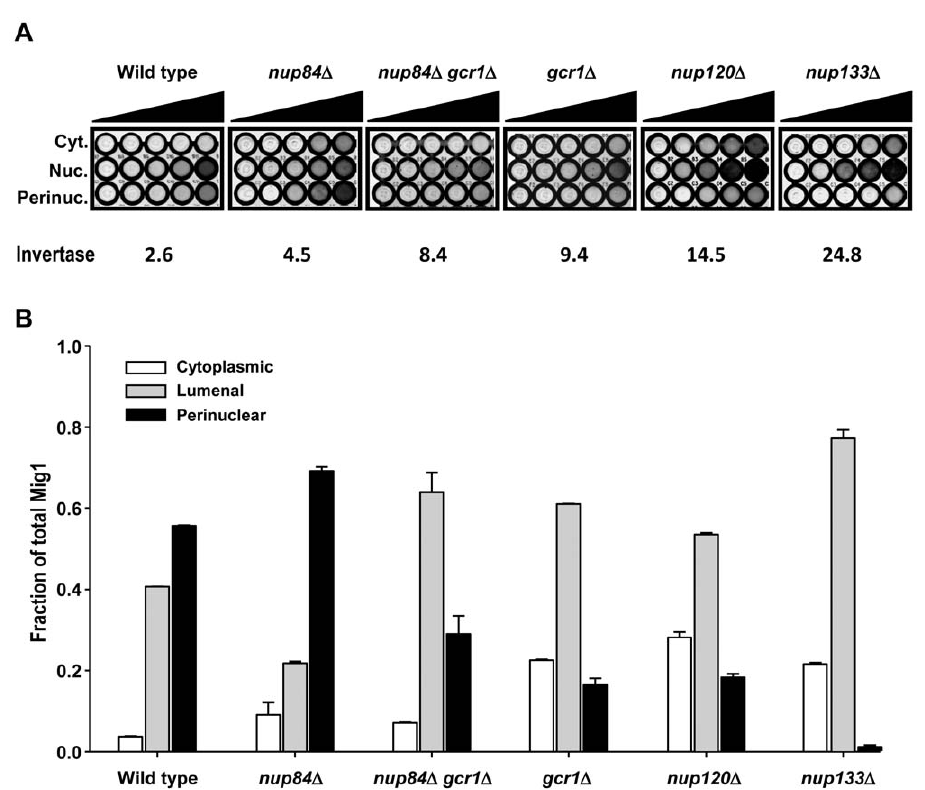
Figure 4. Levels of perinuclear, but not nuclear or total cellular, Mig1, correlate with repression of SUC2 . (A) Quantitative fluorescent protein detection (QFPD) of Mig1-GFP in repressing conditions. Increasing amounts of protein from cytoplasmic, nuclear (perinuclear + lumenal), and perinuclear fractions isolated from wild type or mutant strains were loaded into microtiter wells (circles, left to right); fluorescence was measured as described in Materials & Methods. Units of invertase, also in repressing conditions, are shown for comparison. (B) Densitometric analysis of the data shown in A. The fraction of Mig1-GFP present in the cytoplasm (cytoplasmic; open bars), nuclear lumen (lumenal; shaded bars), and perinuclear compartment (perinuclear; filled bars) is shown for each strain. Error bars represent the standard error of the mean.